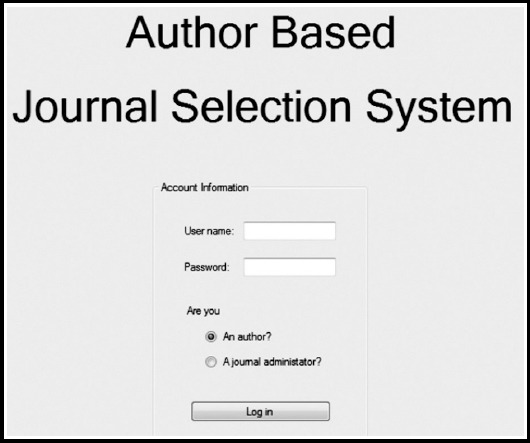
The login screen.